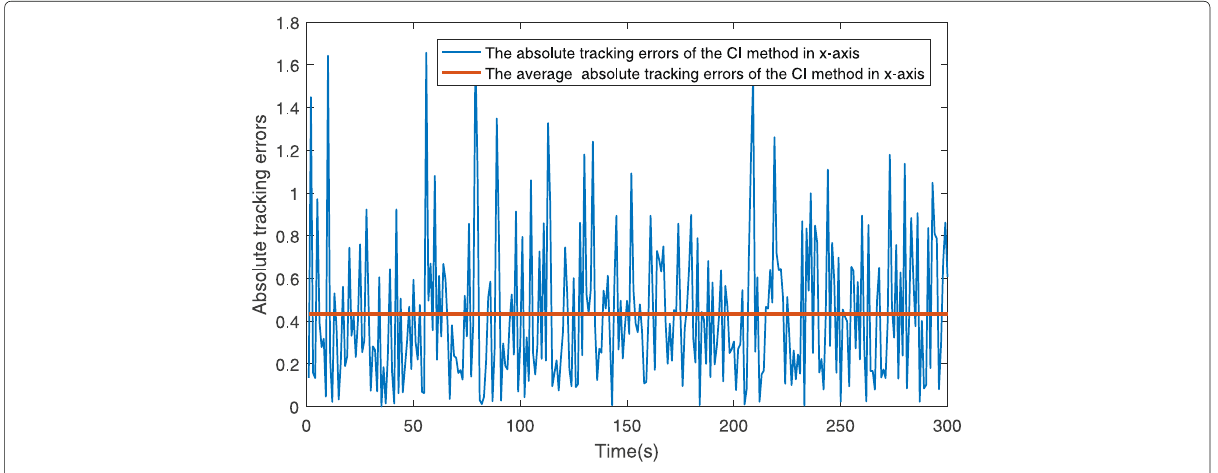
With 50 Monte Carlo simulations, the average absolute tracking errors of the RFE and centralized fusion are presented in Figs. 22, 23, 24, and 25.